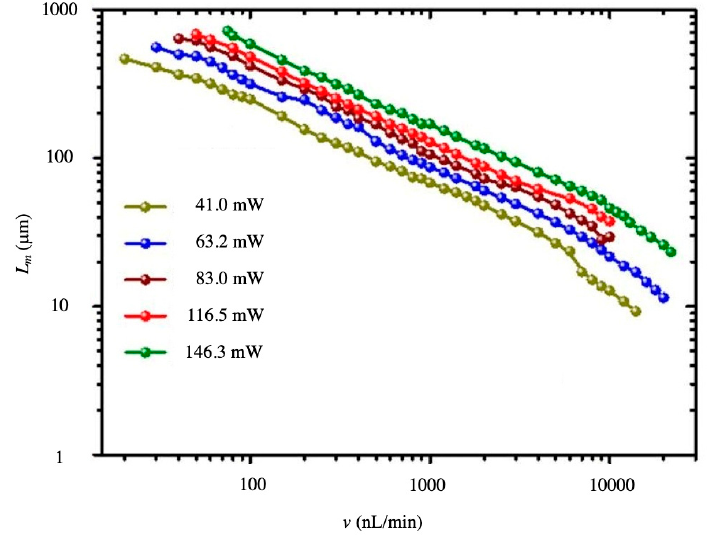
Figure 9. The performance of the flow rate sensing with the stable combined optical trap (SCOT) based on the cleaved single mode fiber (SMF) [62].